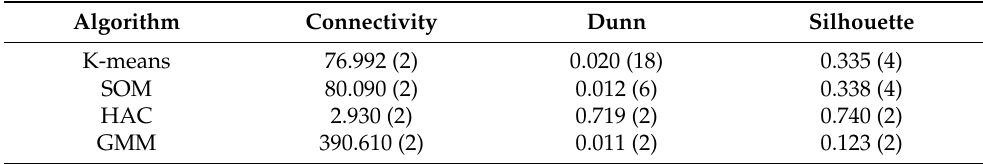
Table 3. Values of indexes that were used to assess the internal validity of the clustering algorithms. The values refer to the score obtained with the optimal number of clusters, which is reported in